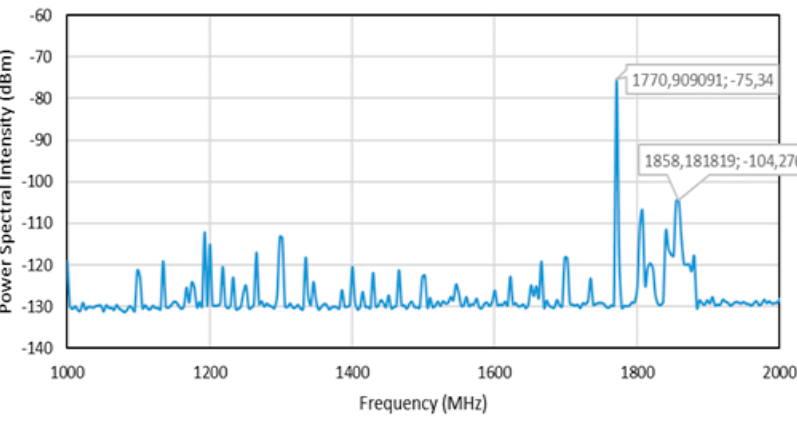
Figure 12. Recent measurements at frequencies 1000–2000 MHz.